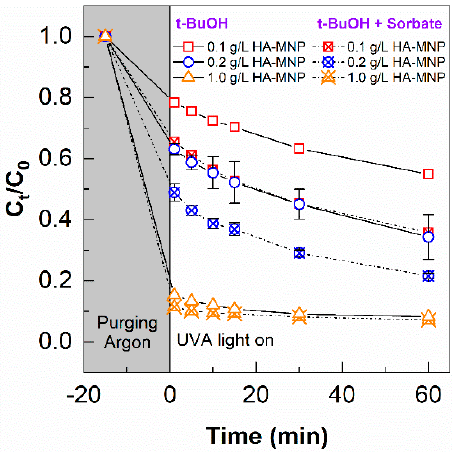
Figure 9. The removal of As(III) in the presence of •OH and 3 HA-MNP* quenchers and in the absence of molecular oxygen during photo-irradiation for 60 min. [As(III)] 0 = 200 µg L − 1 , [HA-MNP] = 0.1, 0.2, and 1.0 g L − 1 , [ t -BuOH] = 10 mM, and [sorbate] = 10 mM; error bars represent the standard deviation of triplicate measurements.